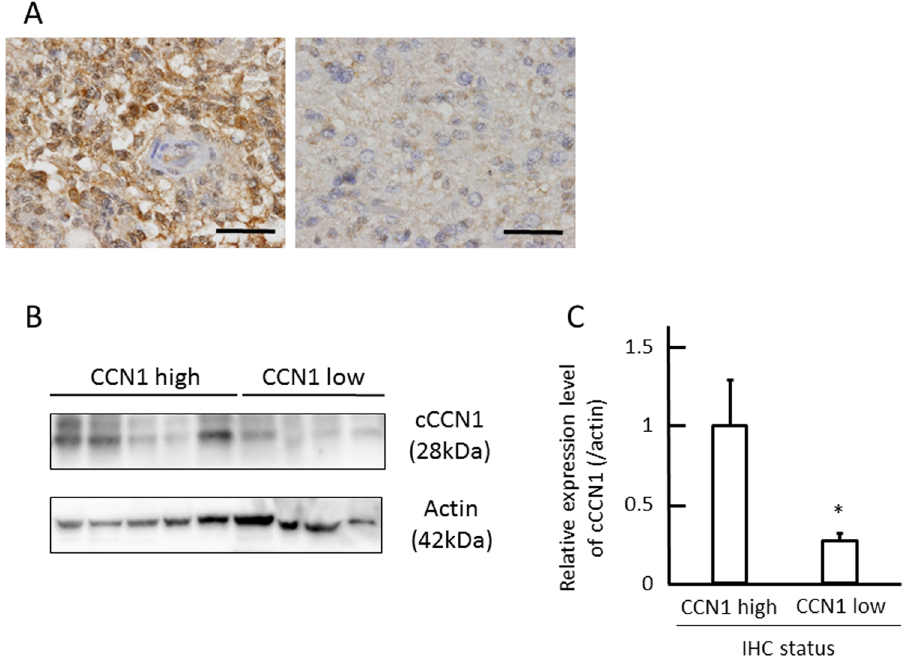
Figure 1. The relationship between CCN1 in immunohistochemical staining and cleaved CCN1 (cCCN1) in western blotting. ( A ) Representative immunohistochemical staining of CCN1 expression in glioblastoma multiforme patients. The photomicrographs show Left; CCN1 high, Right; CCN1 low. Scale bar = 50 μ m. ( B , C ) Expression level of the NH2-terminal fragment of CCN1 protein (cCCN1, 28 kDa) determined by western blotting compared with immunohistochemical staining of CCN1 performed on formalin-fixed paraffin- embedded tissues from 16 corresponding tumors. Correlation was assessed using the Mann-Whitney U test with p < 0.05 considered as significant. Data are shown as the mean ± SEM. Full-length blots are presented in Supplementary Figure